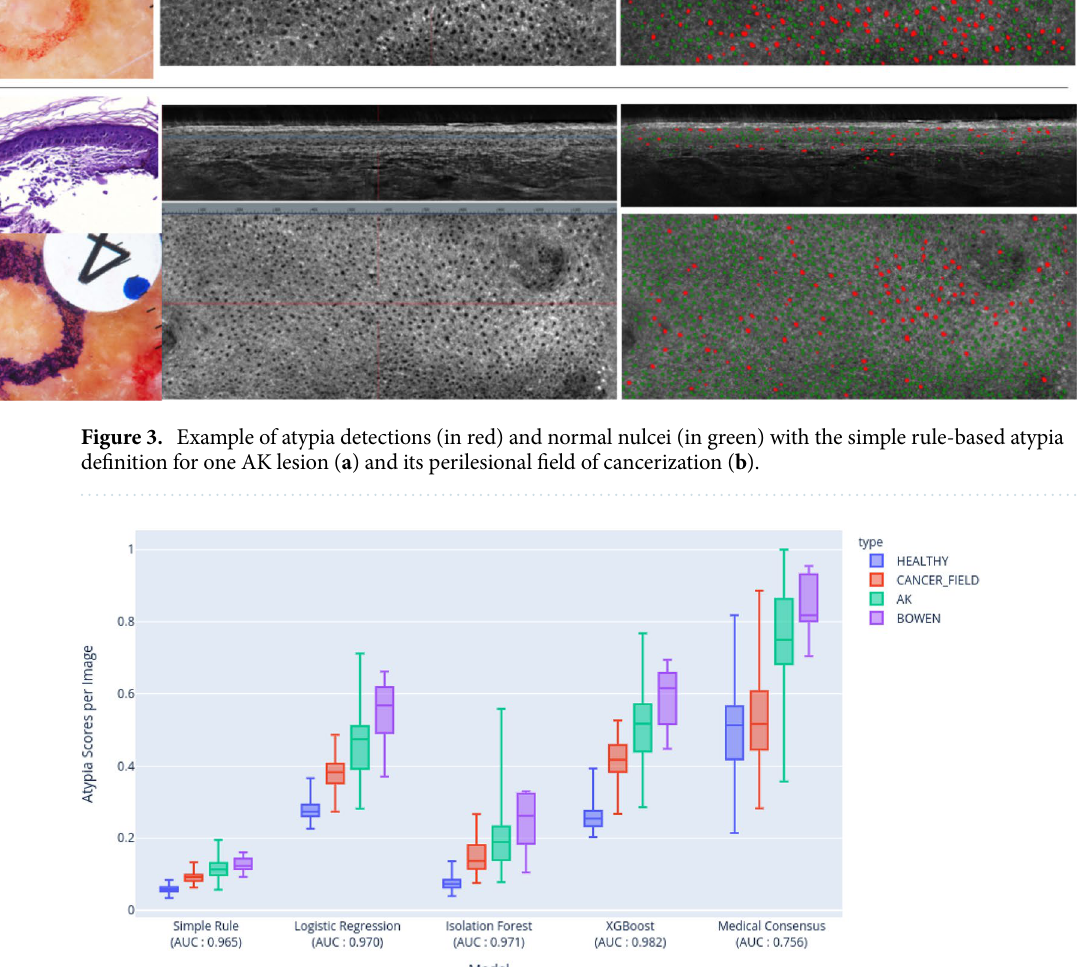
Figure 4. Box plots (min, max, median, q1, q3) of average atypia score per stack for different methods including medical consensus from the reader study. The medical consensus has a much lower AUC score than the other automated